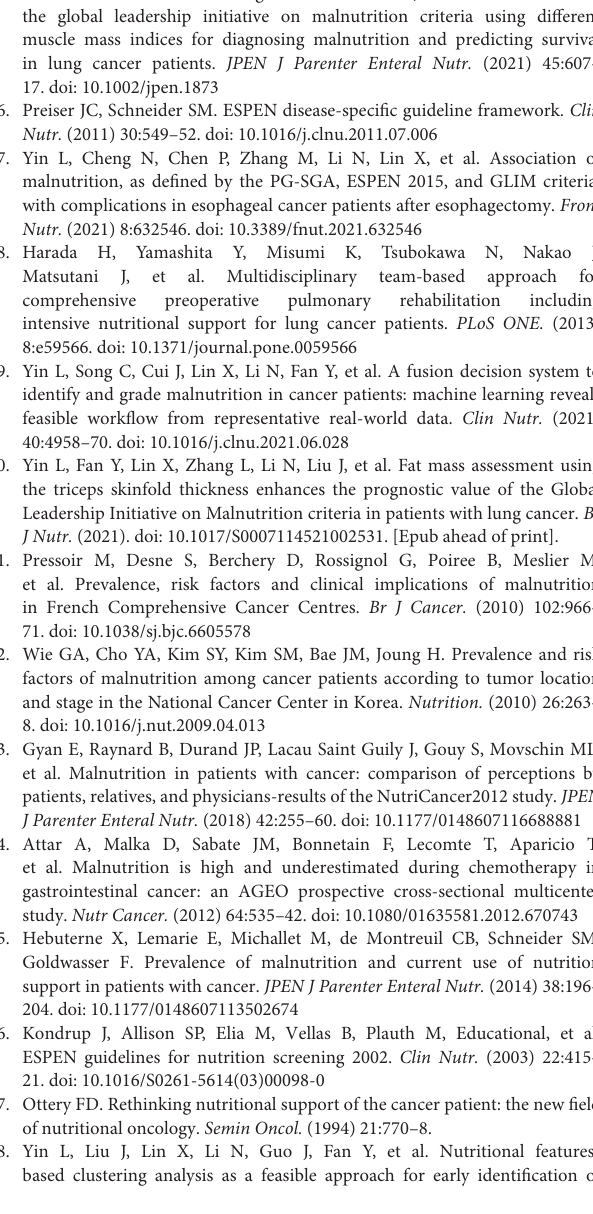
Supplementary Figure 1 | A flow chart of the patient inclusion. Supplementary Table 1 | Inclusion and exclusion criteria for the INSCOC project. Supplementary Table 2 | Approaches and instruments used to obtain the anthropometric information in the present study. Supplementary Table 3 | The different coefficients of each parameter in the fat-age-inflammation (FAIN) index and the corresponding C-index. Supplementary Table 4 | Baseline characteristics of the validation lung cancer